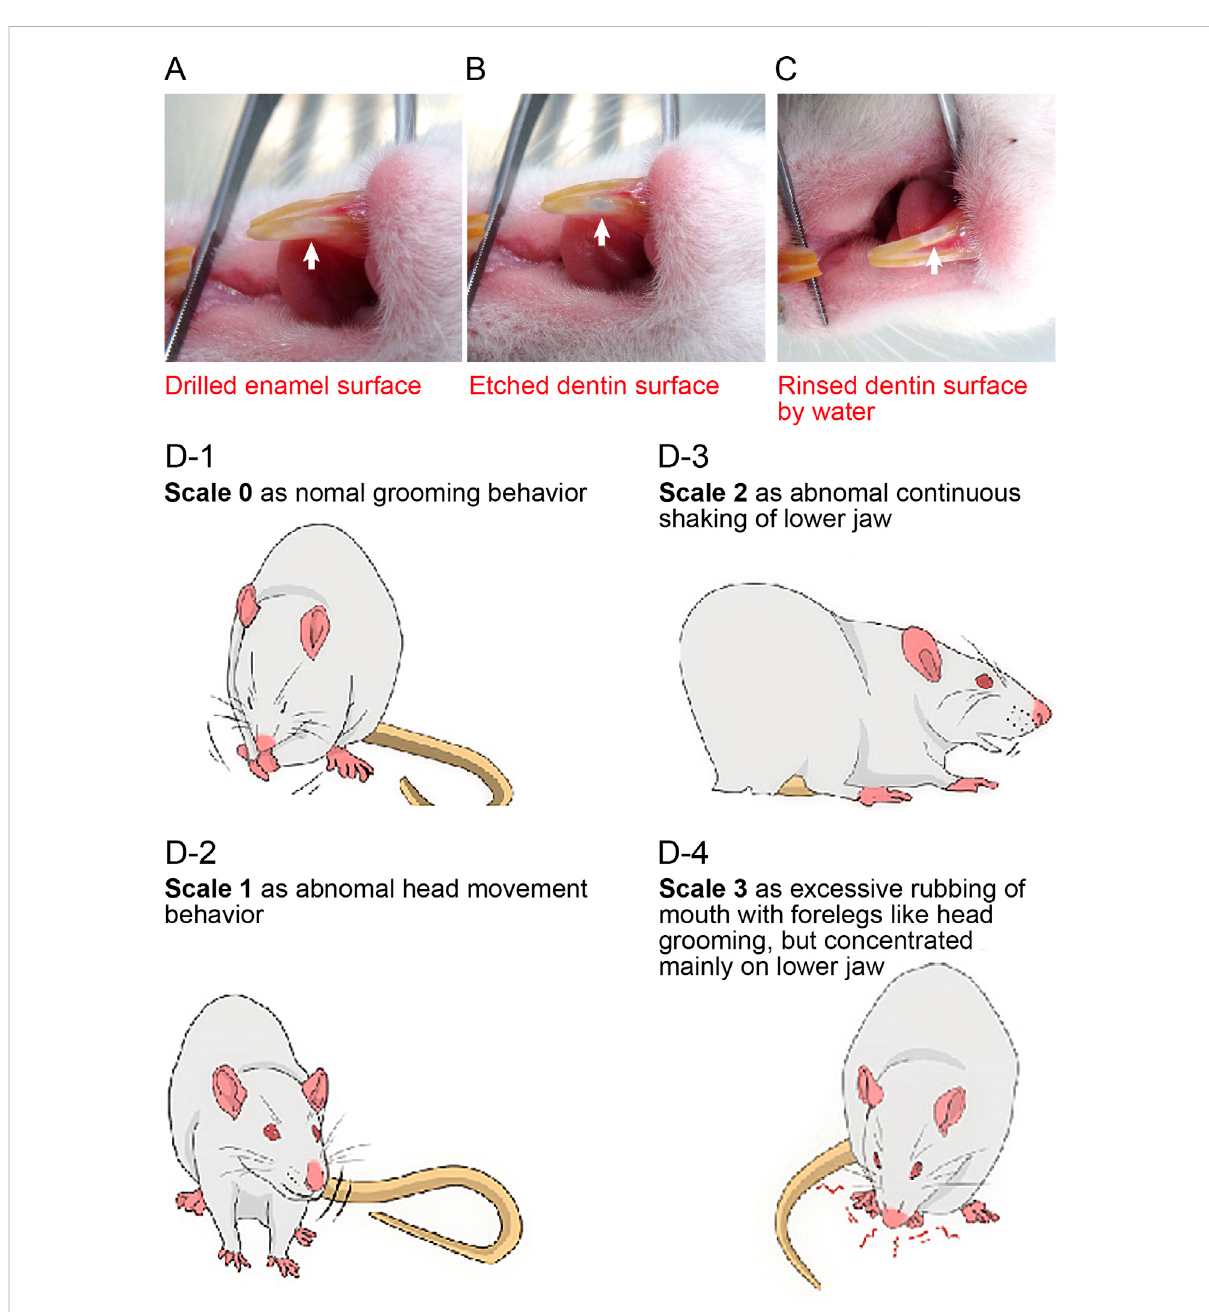
Preparation procedure for dentin exposure in mandibular incisors and evaluation of nociceptive scales (A – C) Photographs showing the preparation procedures to expose dentin of the incisors. We drilled a 1-mm-wide cavity in the enamel of the lower incisor to expose the dentin surfaceatthe1-mmrostralendofthegingivalmargin (A) .Formolars,wedrilleda1-mmdiameterintheenameltoexposethedentinsurface,butnot thepulpchamber,atthecenteroftheocclusalsurfaceoftherightlower fi rstmolar.Theexposeddentinsurfacewasthenetchedtoremovethe smear layer (B) . The etched surface was rinsed with water to wash off the acid agent (C) . (D) Rats and mice were allowed to move freely in a clear acrylic gauge (45 cm × 30 cm × 30 cm) with a mirror to acclimatize them to the environment. Nociceptive behavior was measured for 180 s after stimulation and classi fi ed on a nociceptive scale from 0 to 3. A scale of 0 was de fi ned as normal behavior, such as grooming (D-1) . A scale of 1 was chosenwhenratsormiceshowedabnormalheadmovementsormildheadshaking (D-2) .Ascaleof2indicatesabnormalcontinuous shakingofthe lower jaw (D-3) . A scale of 3 was chosen when they showed excessive rubbing of the mouth with foreleg movements, such as head grooming, but concentratedmainlyinthelowerjaw (D-4) .Fromthesescales,